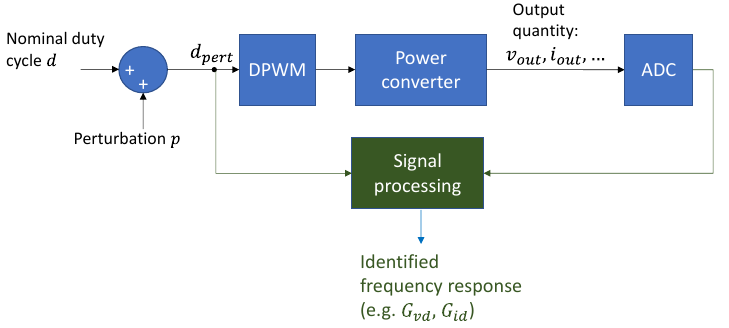
Figure 1. Basic blocks involved in the identification of a power converter.